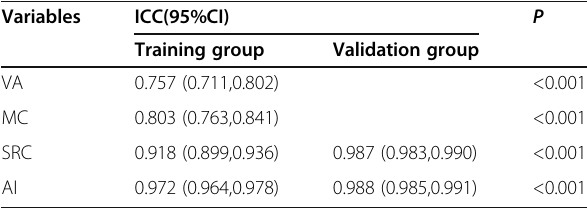
standard comparison card, AI artificial intelligence, LI Label